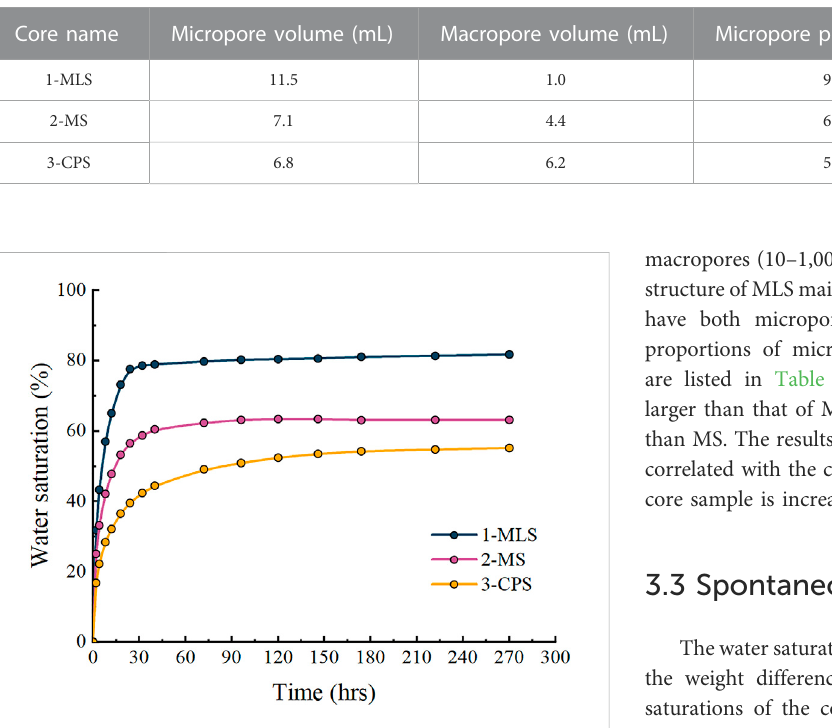
FIGURE 6 Water saturation curves for different cores changed with